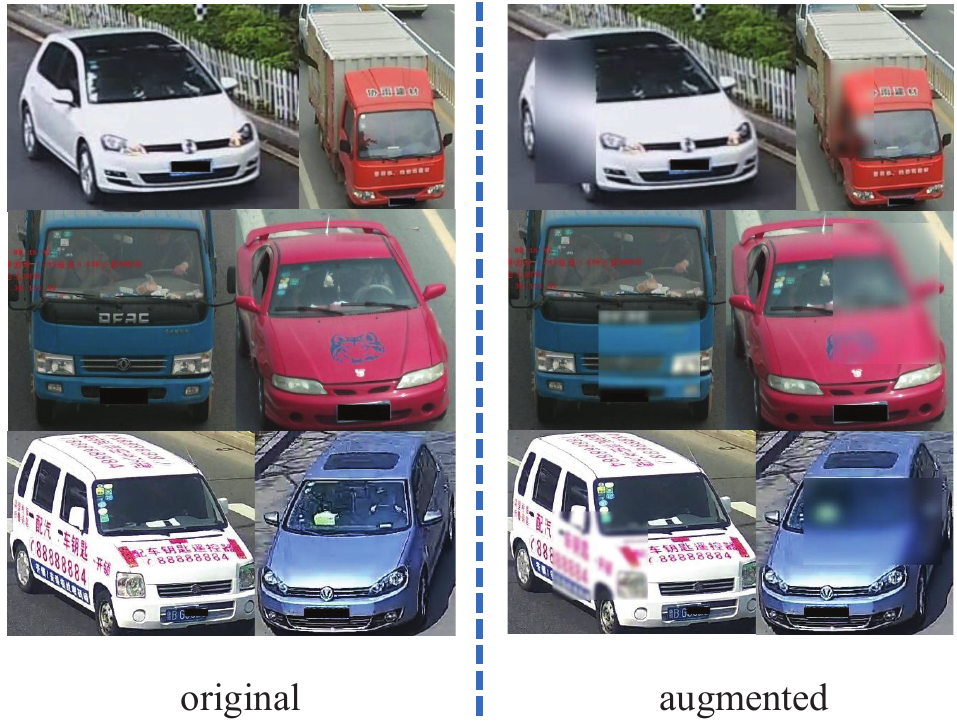
Figure 1. Image augmentation results of our proposed